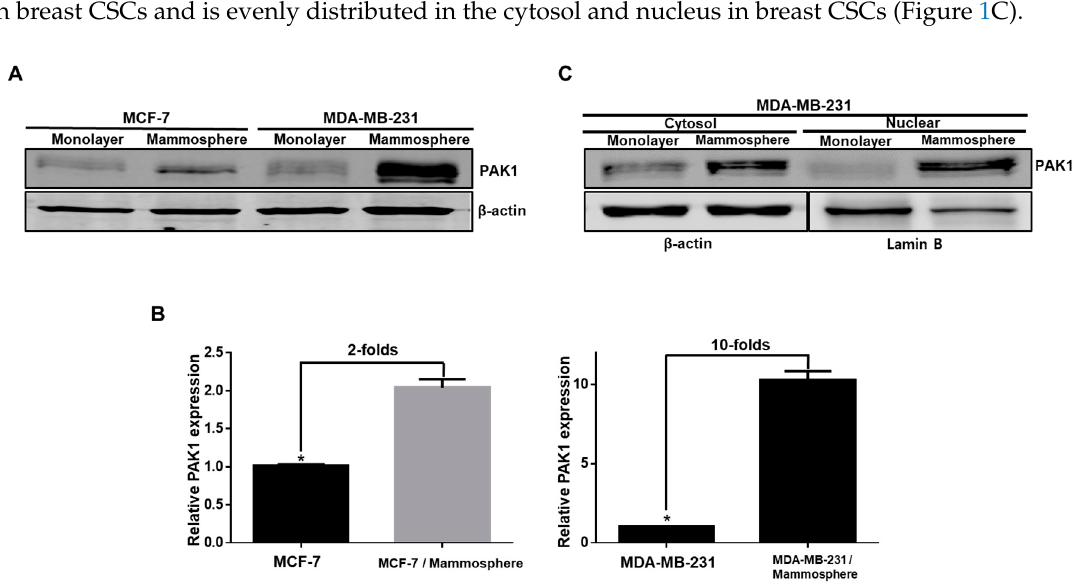
Figure 1. Analysis of PAK1 protein levels in breast cancer stem cells (CSCs). ( A ) Expression levels of PAK1 protein in breast cancer and CSCs. The expression levels of PAK1 were determined in breast cancer and CSCs by immunoblot using a PAK1 antibody and β -actin. ( B ) Relative expression of PAK1 in breast cancer and CSCs was estimated by densitometry. ( C ) Expression levels of cytosolic and nuclear PAK1 protein in breast cancer and CSCs derived from MDA-MB-231 cells. Cytosolic and nuclear PAK1 expression were analyzed in breast cancer and CSCs by immunoblot analysis using a PAK1 antibody. The data are presented as the mean ± SD; n = 3; * p < 0.05 vs. control.